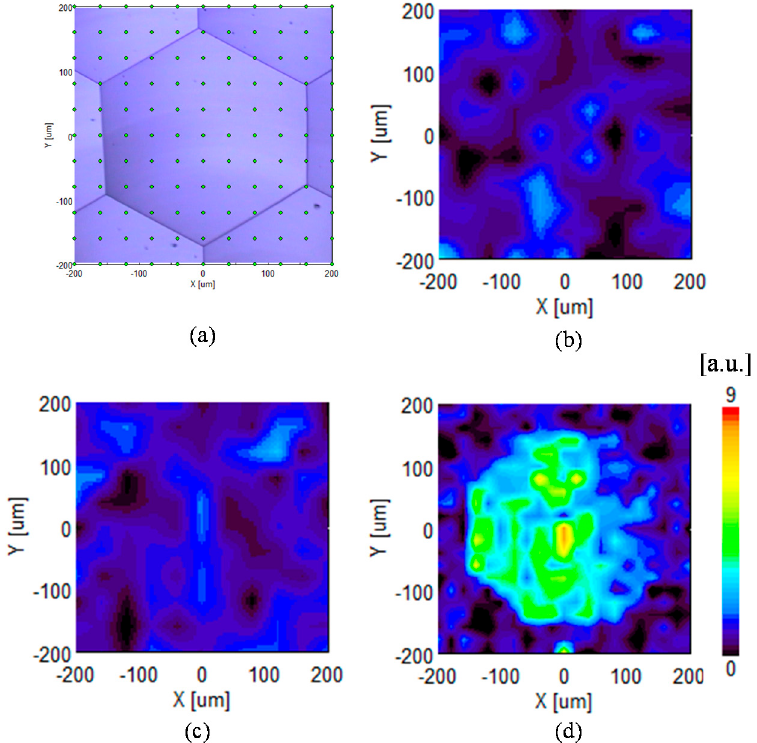
Figure 20. Mapping measurement of peak intensity of amorphous silicon using a laser micro-Raman spectrometer: ( a ) distribution of measurement points; ( b ) mapping result for the lenslet located at x = 0 µ m, y = 480 µ m and ( c ) y = 960 µ m; ( d ) is mapping result for a circular dimple at a higher feed rate ( f = 6 µ m/rev), showing higher intensity.